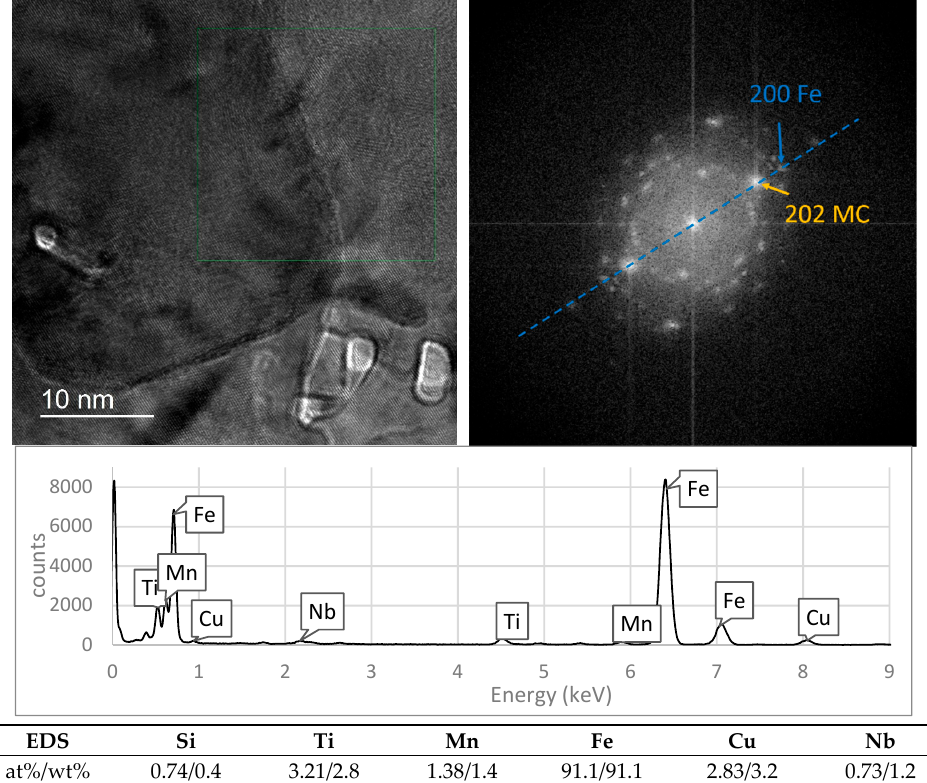
Figure 8. HRTEM, Fast Fourier Transform, and EDS results of a (Ti,Nb)(C,N) precipitate (big) in low-Nb steel austenitized at 1200 °C for 1 h.